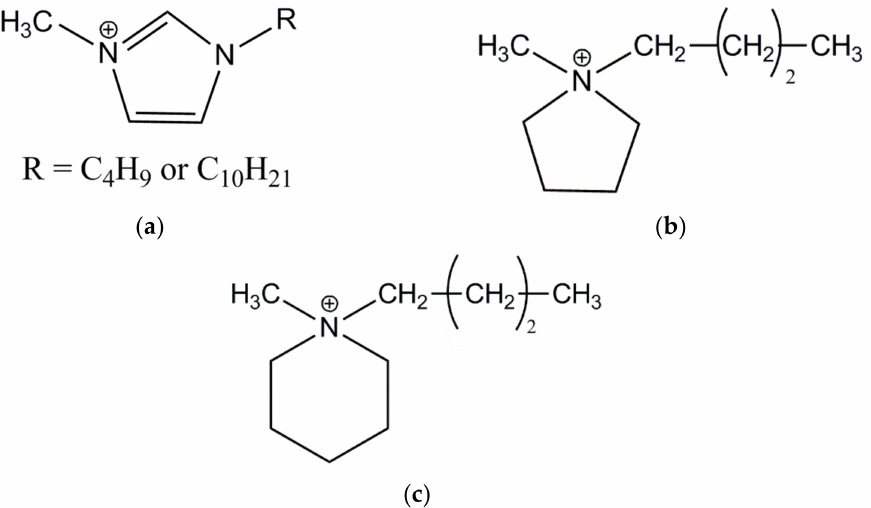
Figure 1. Structure of IL cations (R-alkyl substituent): ( a ) imidazolium; ( b ) pyrrolidinium; ( c )